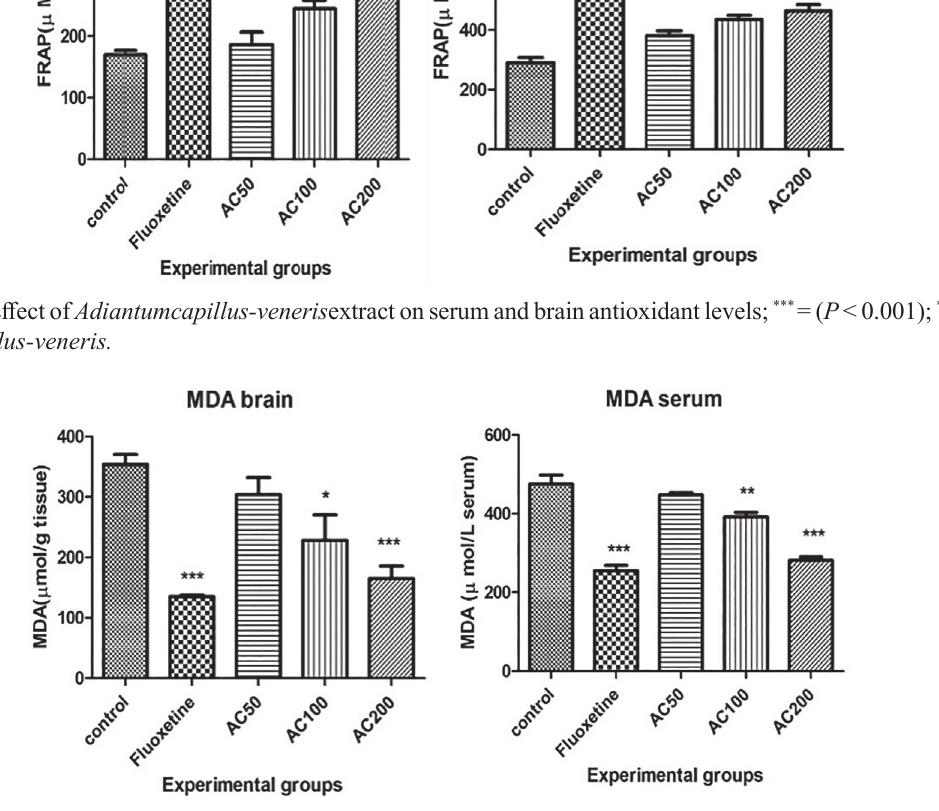
FIGURE 5 (A, B) - 5- The effect of Adiantum capillus-veneris extract on serum and brain malondialdehyde levels; *** = ( P < 0.001);